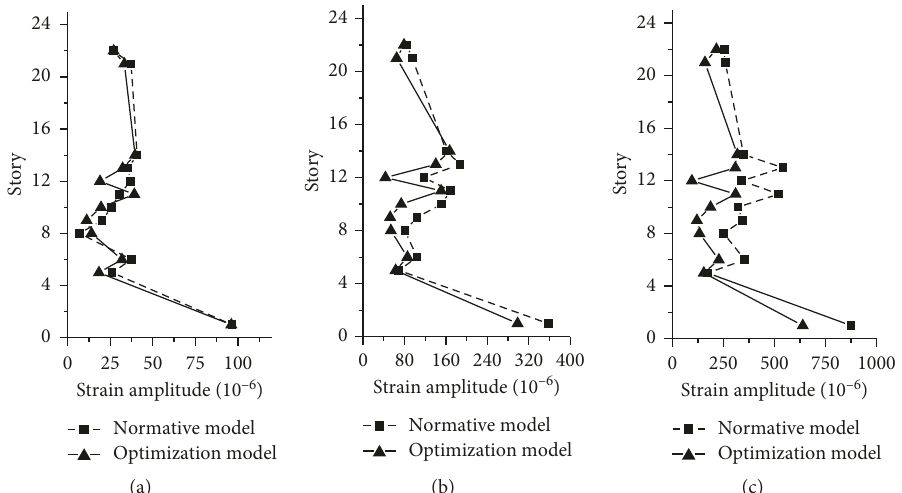
Figure 10: Maximum strain value of frame column at different story. (a) Frequent intensity 7, (b) basic intensity 7, and (c) rare intensity 7.